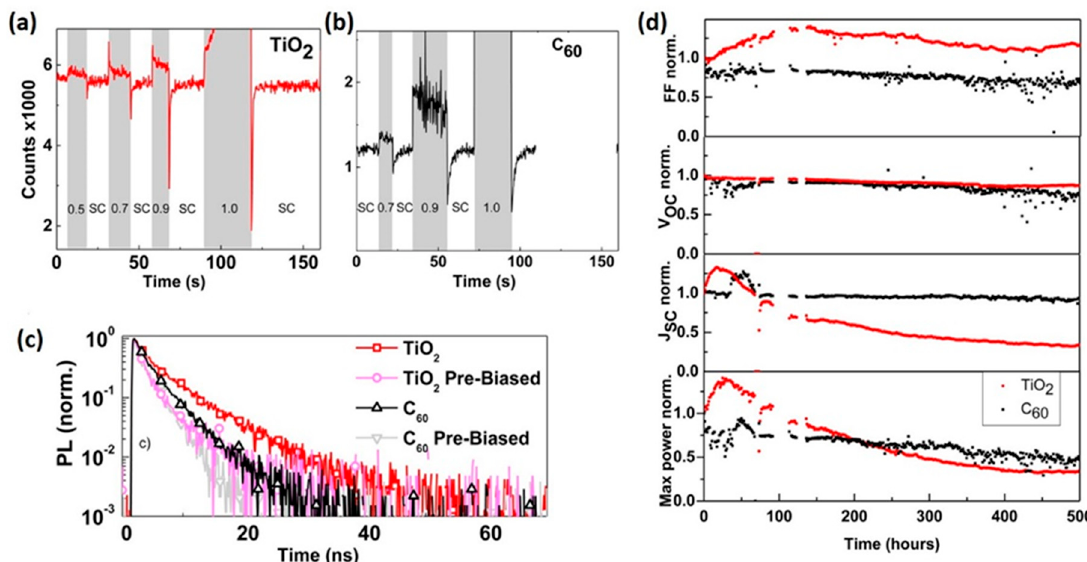
Figure 7. Steady state PL measured over time with ( a ) compact TiO 2 or ( b ) C 60 acceptor electron transport layers (ETLs) at short circuit and different forward biases. ( c ) Time resolved PL decays for the devices before and after applying 1 V forward bias. The pre-biased devices are measured within 3 s after applying the forward bias. ( d ) Photovoltaic parameters extracted from J-V curves for both cells after heat treatment at 60 °C for 500 h. J-V curves were measured every 65 min. Reprinted with permission from [53]. Copyright (2015) American Chemical Society.